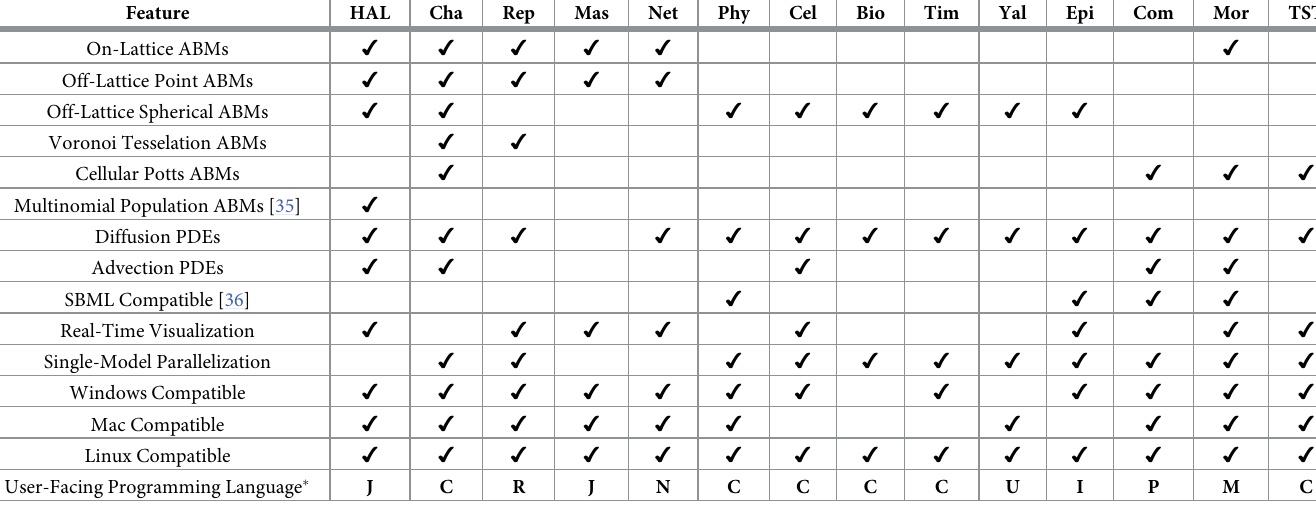
Table 1. Comparison of HAL with other agent-based modeling frameworks commonly used in tissue modeling as of December 2019. Features are marked according to whether there exists a built-in user accessible implementation.